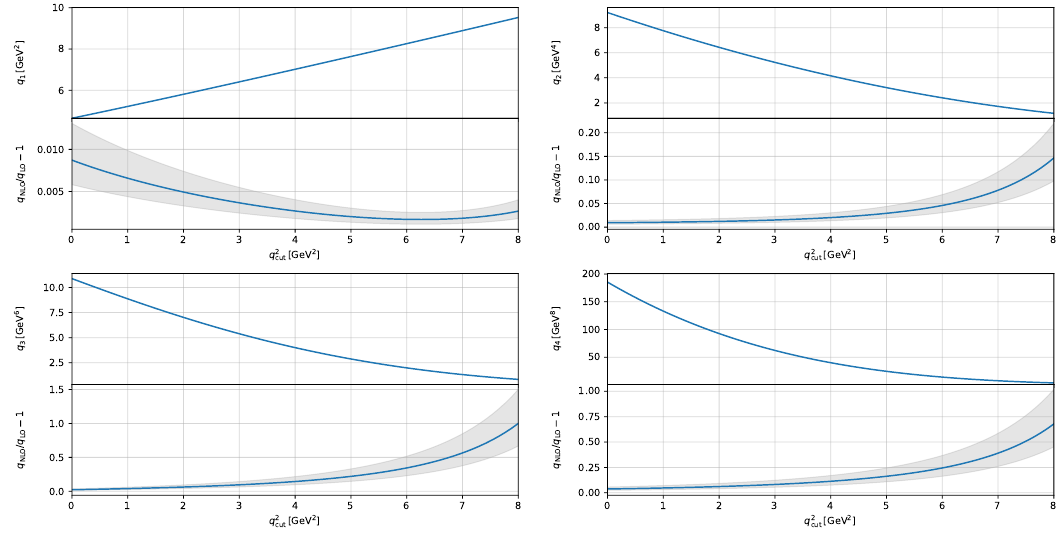
Figure 1 . The first to fourth centralized q 2 moments (upper panels) and the relative size of the α s corrections with respect to the LO (lower panels). The grey area in the ratios represents the error due to variation of the renormalization scale µ s